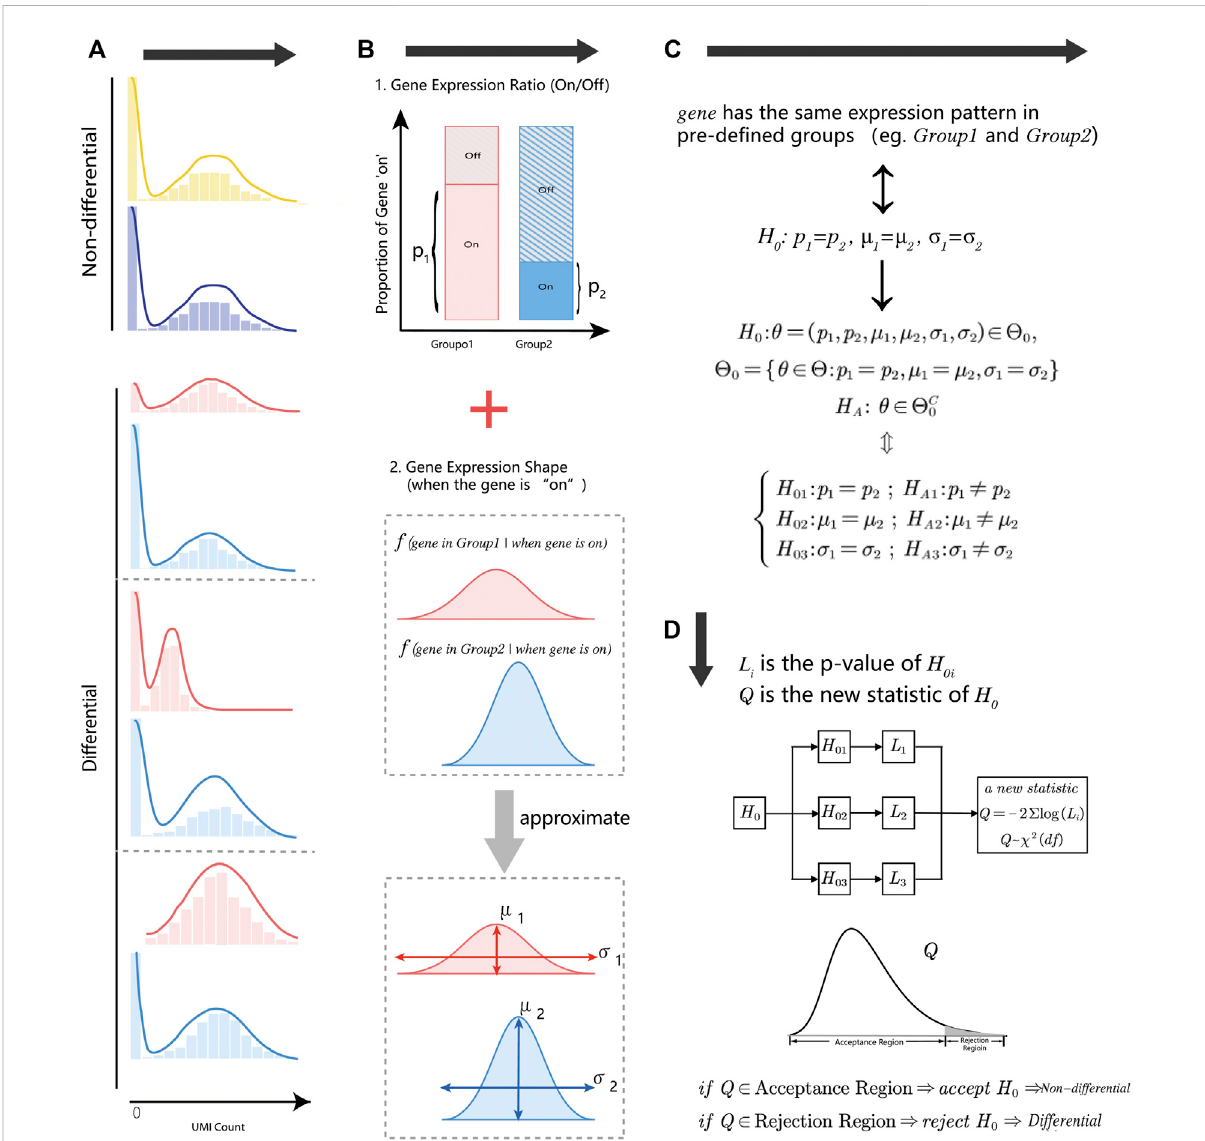
FIGURE 1 An overview of the HEART. (A) Diagram of non-differential and differential gene expression patterns. The non-differential genes have the same statistical distribution in different groups. Differential gene expression patterns have several modes with different characteristics. (B) The gene expression distributiondecomposes into two parts: thegene expressionstate ( “ On/Off ” )and thegene expressionshape when thegene is “ On. ” Two parameters could approximate the distribution shape of the gene “ On ” part: the location parameter μ and the scale parameter σ . (C) HEART ’ s combination statistical test structure. Combination test fl ow